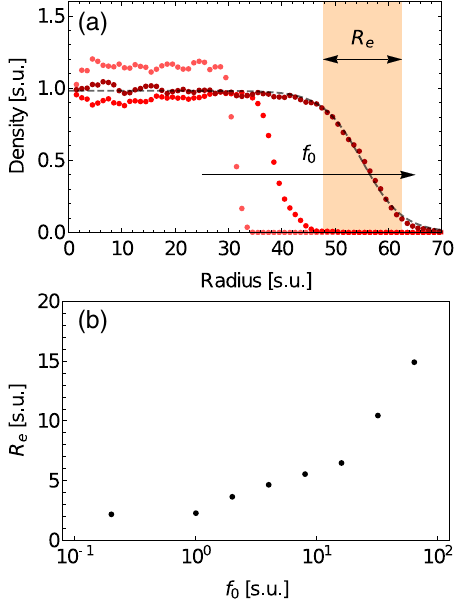
FIG. 16. Influence of the parameters f 0 on the shape of the density profile in simulations. (a) Density profiles for different values of f 0 at the same time step. From lightest to darkest: f 0 ¼ 0 . 2 , f 0 ¼ 16 , and f 0 ¼ 64 . All other parameters, and also FIG. 17. Compartmentalization in the colony as emerging in the simulations, analogous to the glass substrate. In simulations, by the initial conditions, are identical. The black line on the dark red externally saturating the cell speed in a ring at the periphery of the curve is a fit using a hyperbolic tangent, which allows us to tissue, a local modulation of the cell density is seen at the edge. extract the size of the edge (orange box). Note that, contrary to the (a) Modulation of the density and apparition of the C 2 and C 3 results displayed in Fig. 3, no constraint on the velocity of cells at compartments at the tissue edge. (b) Cell speed in the tissue and the border has been applied; therefore, the C 2 and C 3 compart- saturation. The saturation is set to 10 s.u. in a 5 s.u. thick ring. The ments are not reproduced. (b) Size of the edge R as a function of e value of the active force strength Γ is identical for all cells and is the parameter f 0 in the semilogarithmic scale. The value of the set to 0.5 for each graph, as in Fig. 3(b), mimicking the case active force strength Γ is identical for all cells and is set to 0.5 for on each graph.